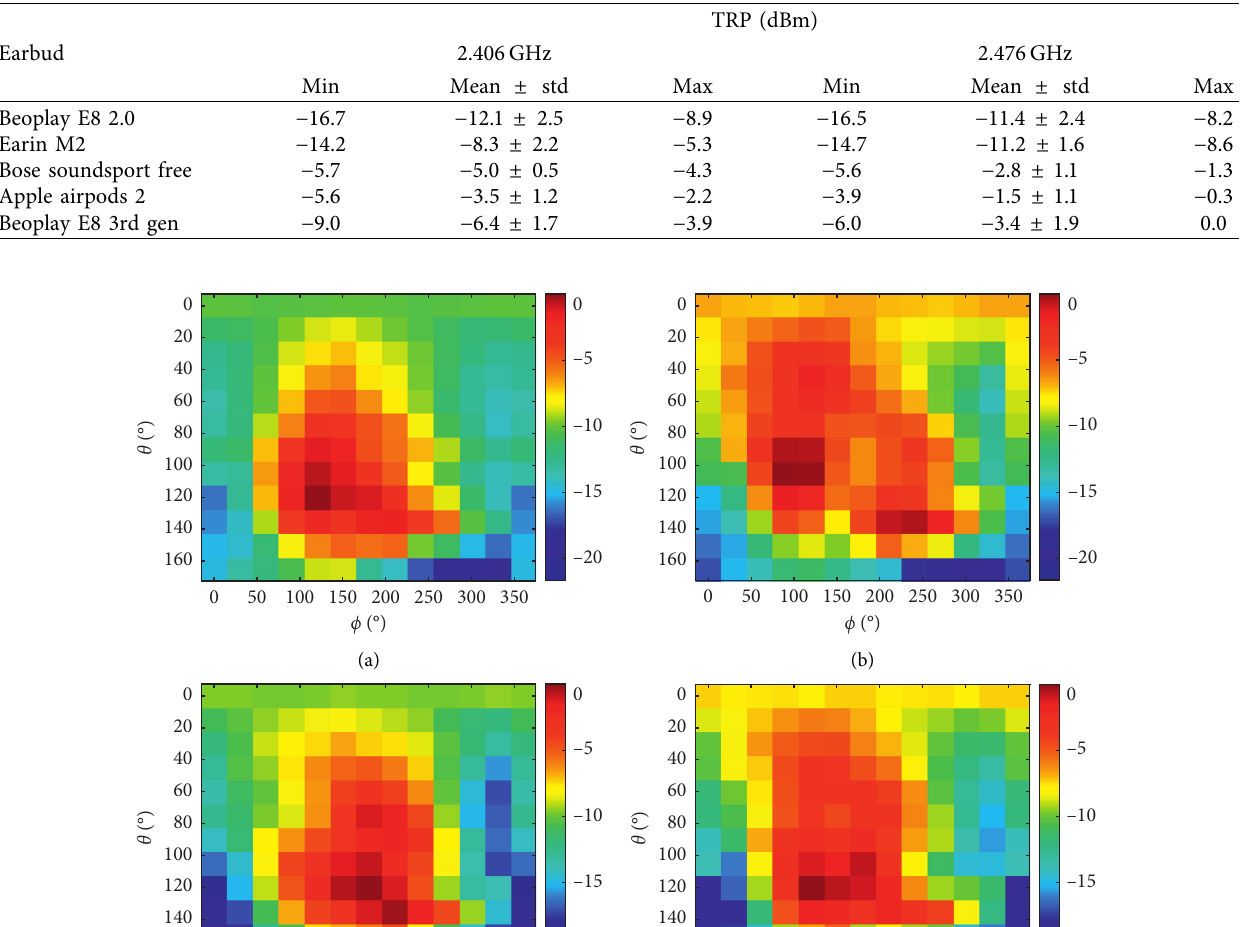
Table 2: Measured TRP when each earbud is placed in the right ear of the volunteer.